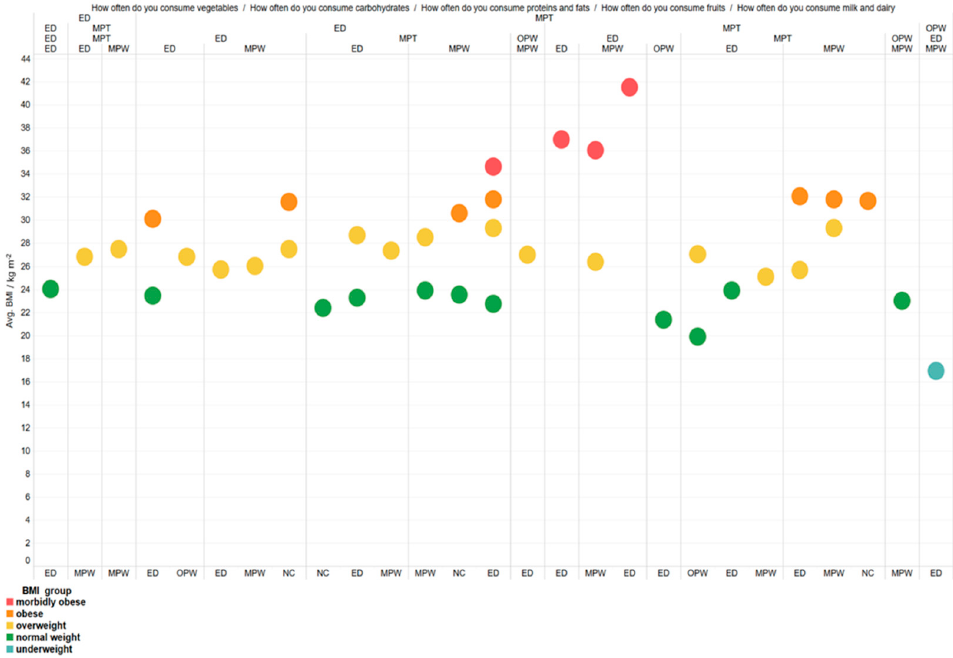
Figure 10. Distribution of users by BMI groups by frequency of intake of macronutrient, milk and dairy products, vegetables, and fruits.